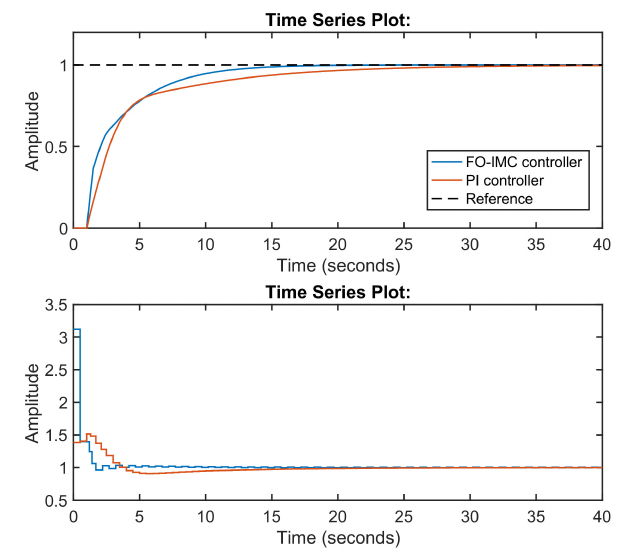
Figure 6. Comparison between the closed loop systems with the event-based FO-IMC and the classical proportional integral PI controllers for reference tracking (output signal in the upper plot, input signal in the lower